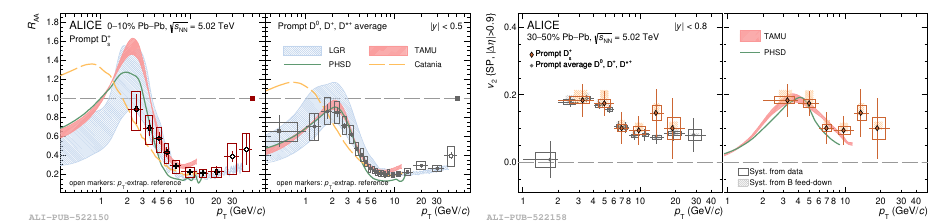
Figure 2. R AA (left) and v 2 (right) of D + s mesons compared with models [3].